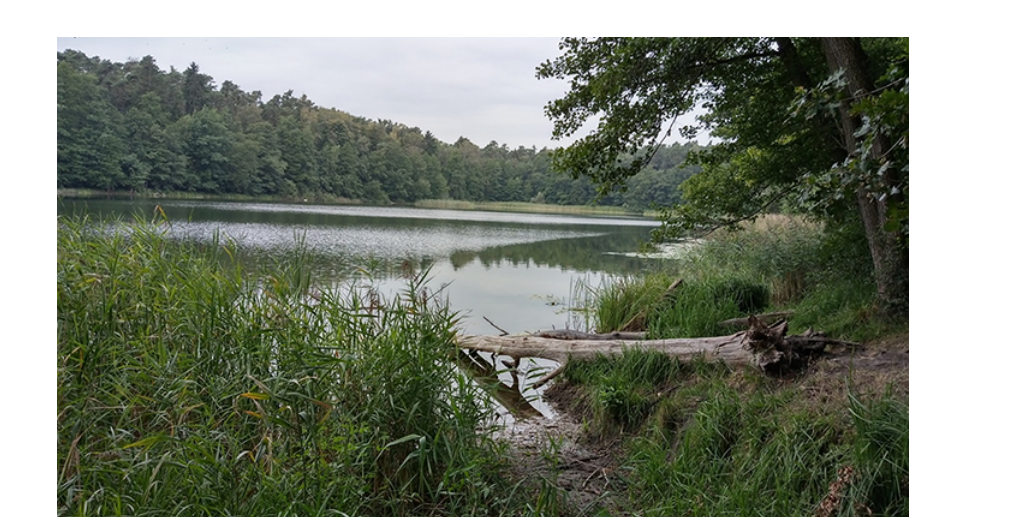
Figure 2 Jarosławieckie Lake – a ribbon lake in between the villages of Jeziory and Trzebaw in the WPN. Photography by Anna